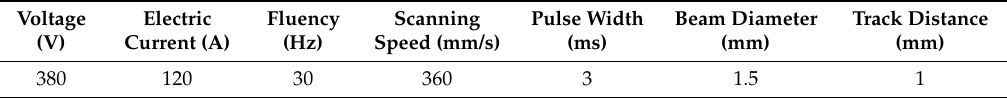
Table 2. Processing parameters for laser cladding and laser